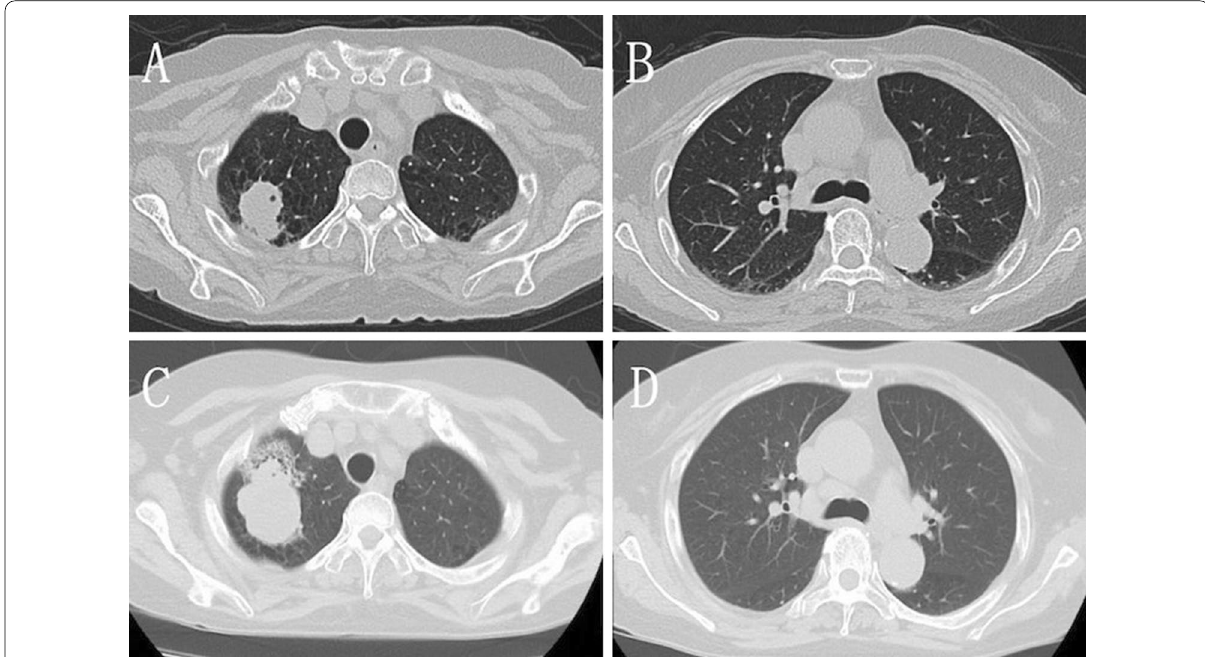
Fig. 1 A Chest computed tomography (CT) scan shows a lobular mass of 33 mm located in the right upper lobe and B lymph node enlargement in station #4R. C Chest CT scan, taken 1 month after consultation, shows that the tumor diameter increased to 52 mm and D lymph node enlargement